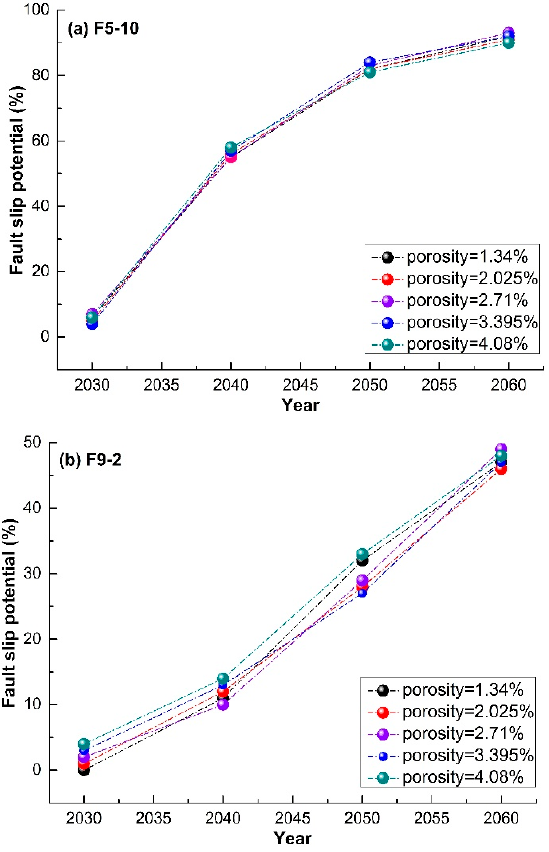
Figure 11. Changes in FSP on segments F5-10 ( a ) and F9-2 ( b ) with increasing